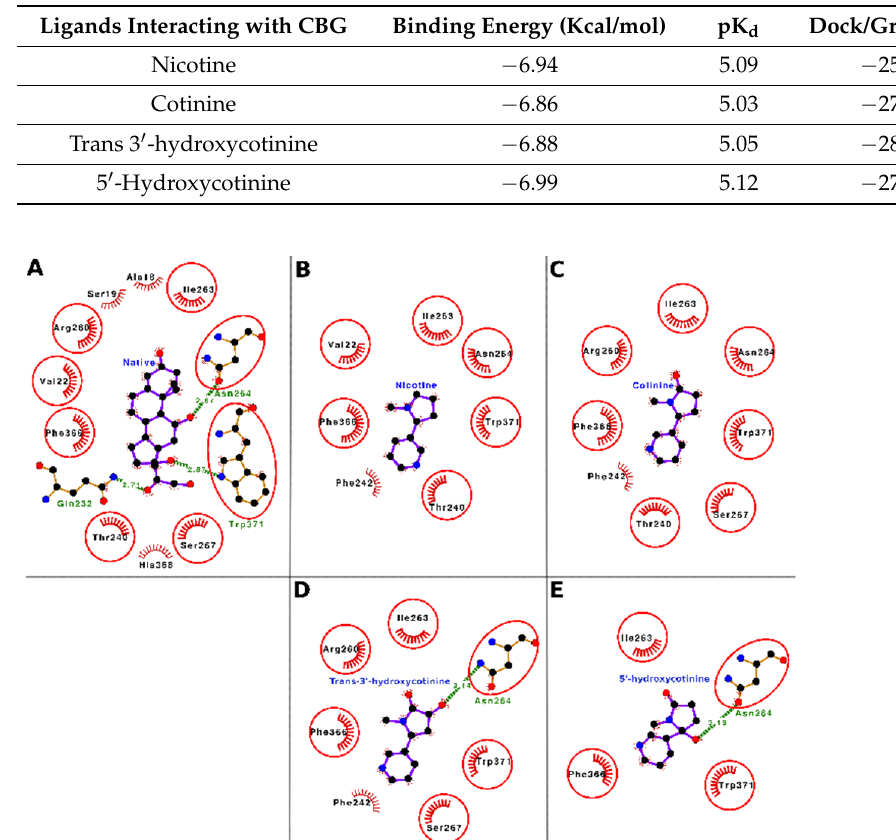
Figure 6. Ligand–protein interaction plots of the native ligand (cortisol; Panel A ), nicotine (Panel B ), cotinine (Panel C ), trans-3 ′ -hydroxycotinine (Panel D ), and 5 ′ -hydroxycotinine (Panel E ) in complex with corticosteroid-binding globulin (CBG). The ligands are placed at the center of each plot surrounded by the interacting residues. The ligands and the residues forming hydrogen bonds are shown in the ball and stick representation. The balls represent the atoms, and the sticks represent the bond between them. The color of the balls differentiates the atom types, i.e., the black balls represent carbon atoms, red balls oxygen atoms, and blue balls nitrogen atoms. The hydrogen bonds are shown as green dashed lines labeled with bond length (in Å). The residues forming nonbonded contacts are shown as arcs with bristles. The interacting residues for ligands which are common with the interacting residues for the native ligand are